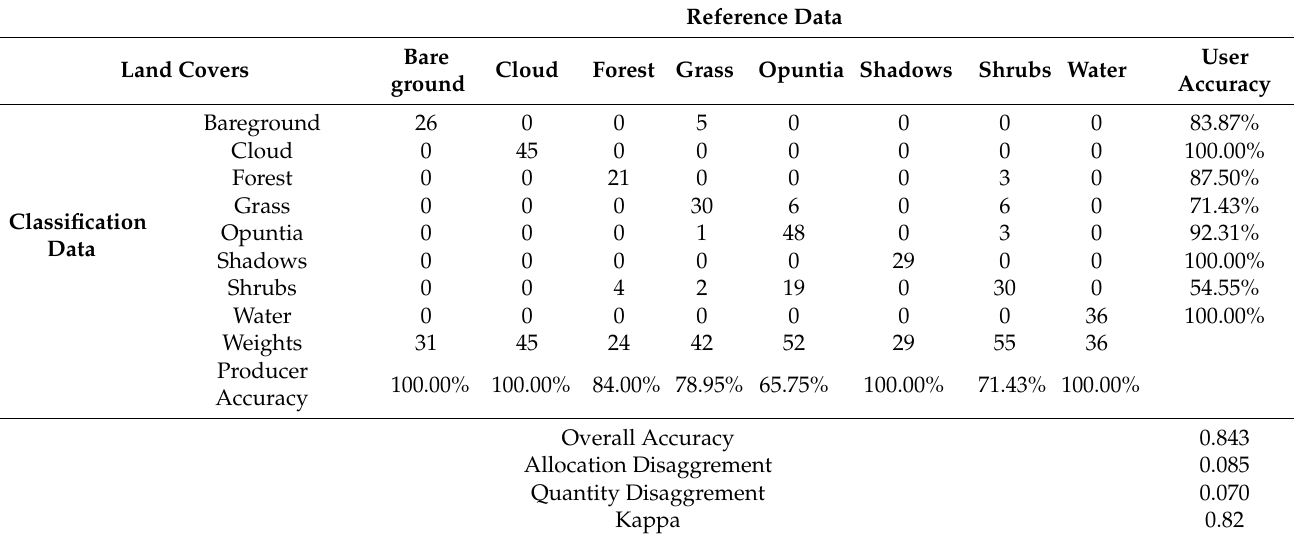
Table 7. Confusion matrix for model 1.b user’s and producer accuracy. The overall weighted accuracy is 0.84 ± 0.036.